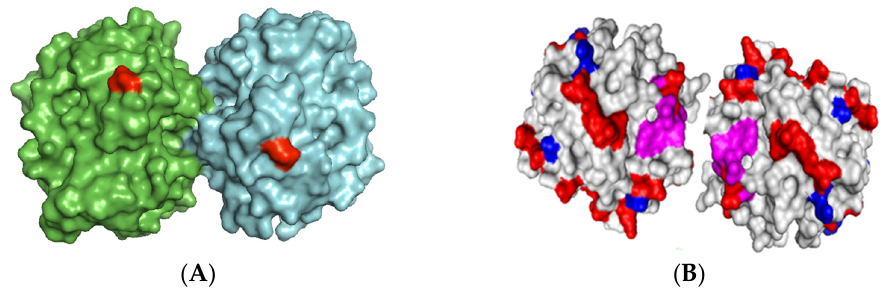
Figure 2. 3D-structure of Thermomyces lanuginosus lipase (TLL) aggregate. Lecitase was designed by genetic modification of TLL [12], so both aggregates should be similar. ( A ): Amino-terminal residues (red). Both amino termini are placed in the same hemisphere and relatively close to each other. ( B ). Carboxyl groups (red), Lysine groups (blue), active center (violet). The region involving both enzyme molecules is very rich in carboxyl groups.